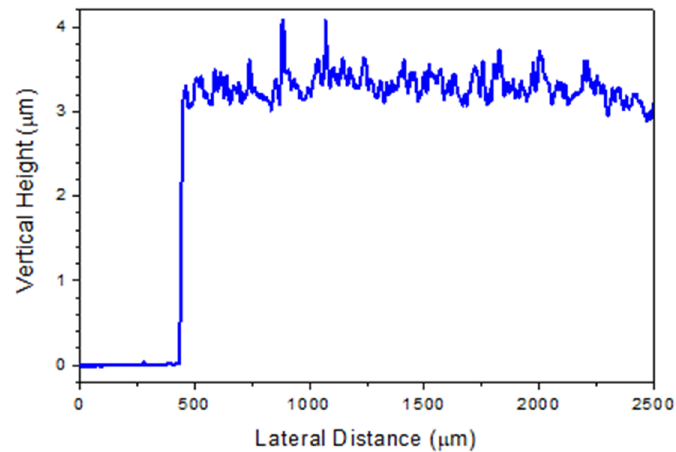
Figure A1. Profilometer profile of a typical nanocellulose sheet.